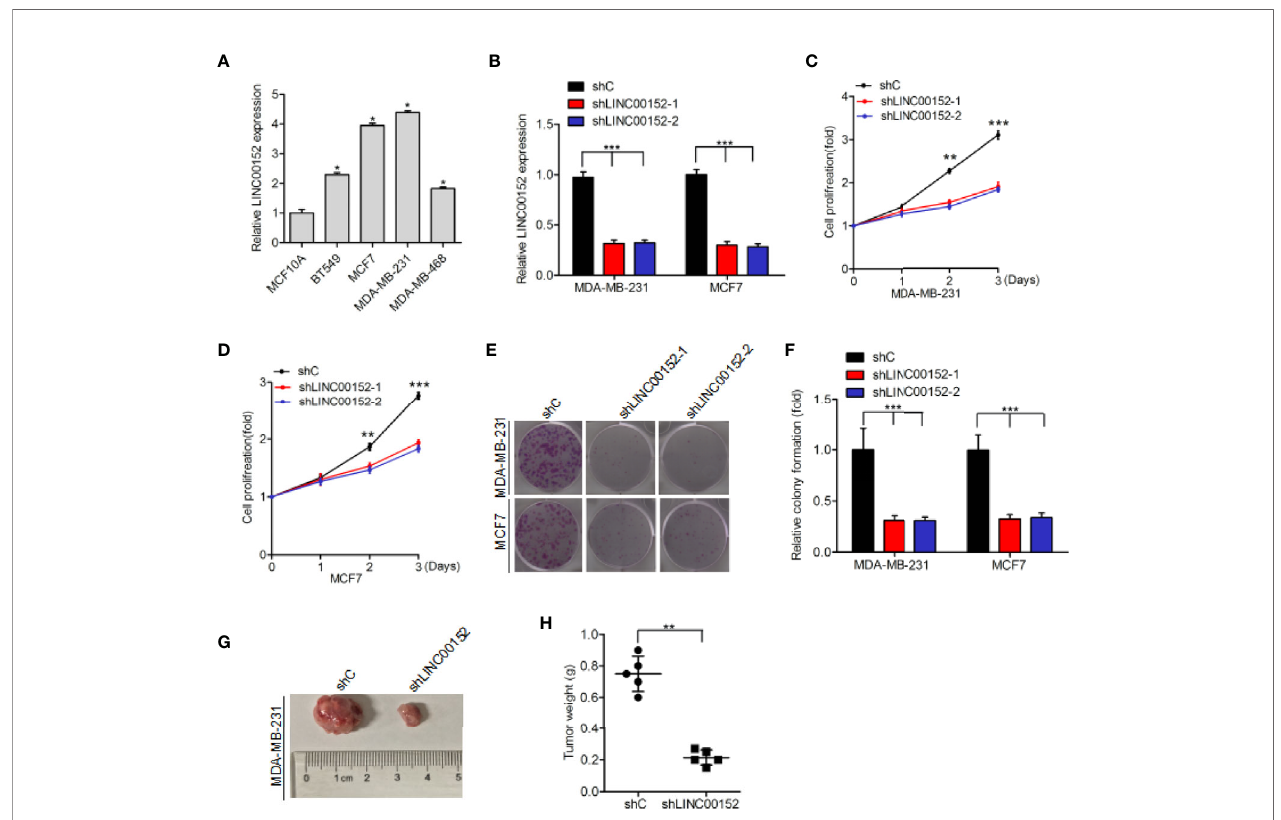
FIGURE 2 | Impact of LINC00152 on the proliferation and tumorigenicity of breast cancer cells. (A) LINC00152 is upregulated in breast cancer cells (BT549, MCF7, MDA-MB-231, and MDA-MB-468) compared to the normal breast epithelium cells (MCF10A). (B) Knockdown of LINC00152 via two shRNAs (shLINC00152-1 and shLINC00152-2) or control shRNA (shC) in MCF7 and MDA-MB-231 cells. (C – E) Knockdown of LINC00152 inhibited cell proliferation (C , D) and colony formation (E) . (F) Quanti fi cation of colony formation in (E) . (G) Representative images of shC- or shLINC00152-infected MDA-MB-231 cells that were transduced when injected into nude mouse gland fat pads. Data were from three independent experiments with fi ve mice per group. (H) Quanti fi cation of tumor weight in (G) . Error bars represent the SD of each value. *P < 0.05, **P < 0.01, ***P < 0.001. Data represent three independent